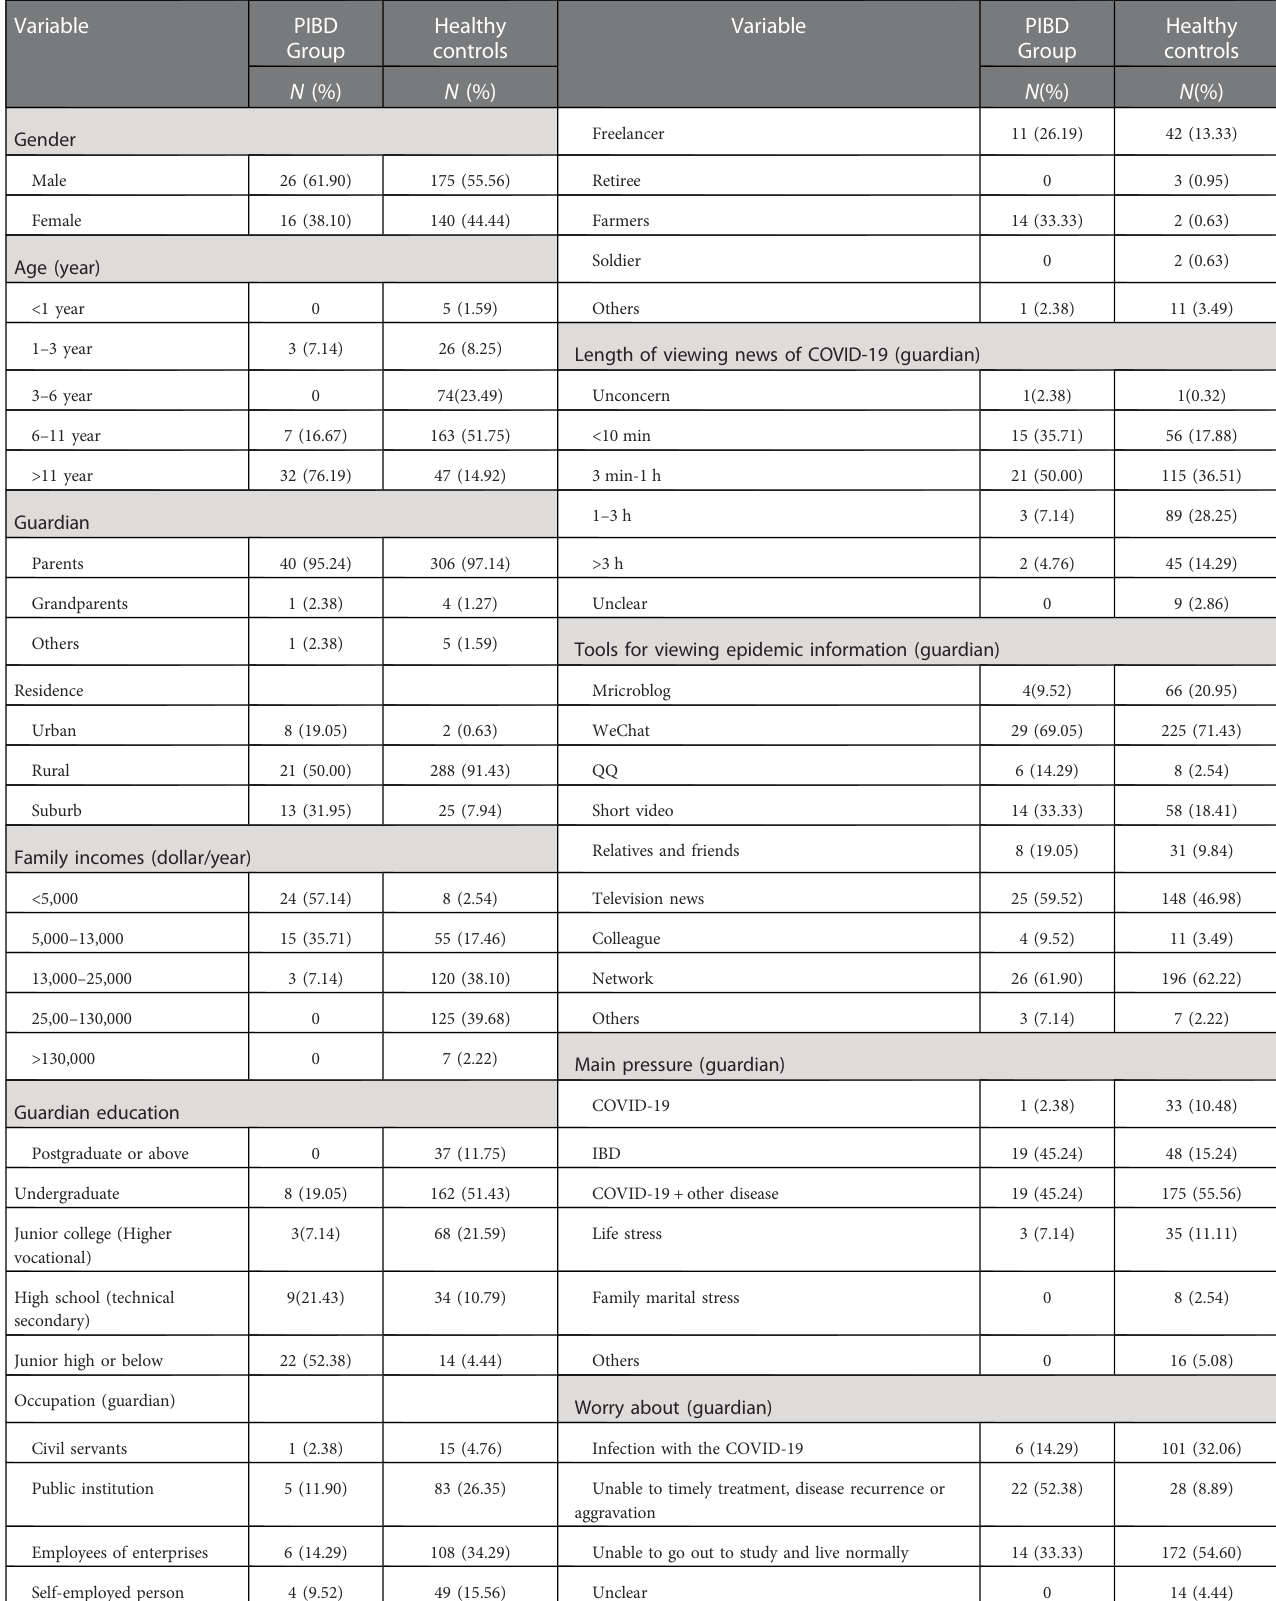
TABLE 4 The general information of PIBD and healthy controls after COVID-19 (N PIBD =42, n healthy =315).